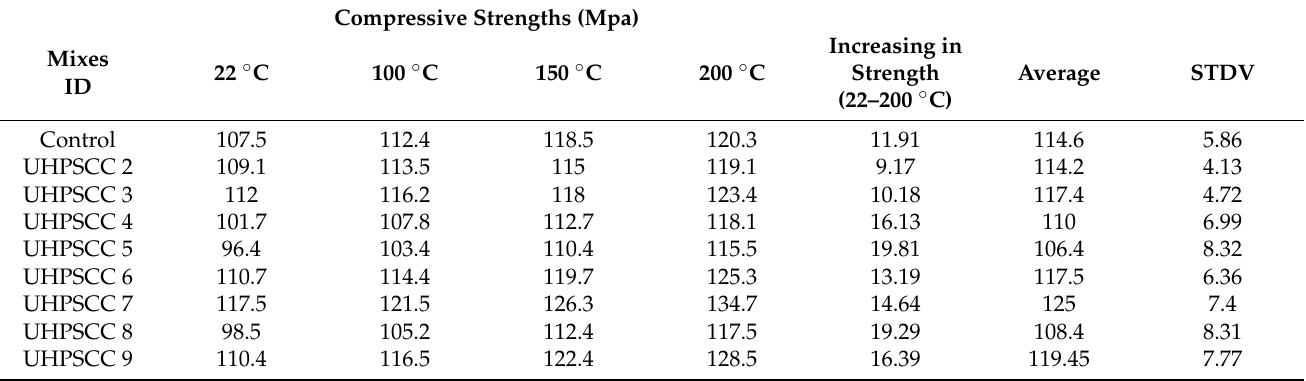
Table 4. Compressive strength results under elevated